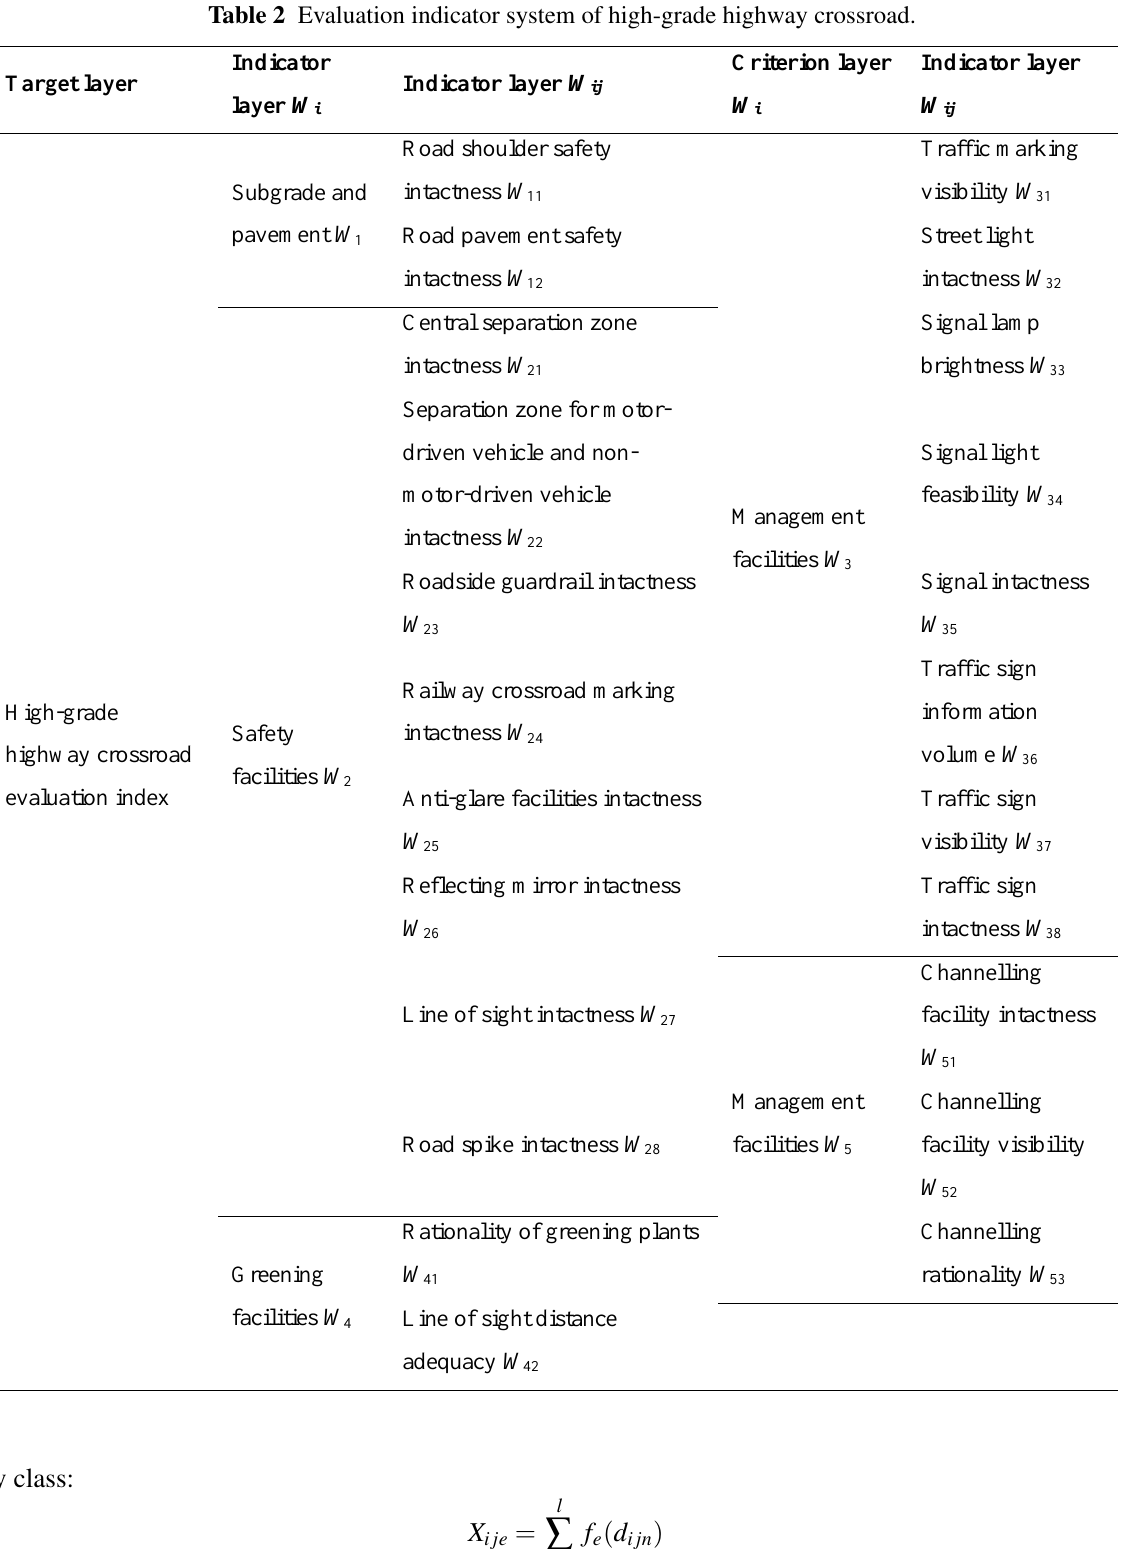
Table 2 Evaluation indicator system of high-grade highway